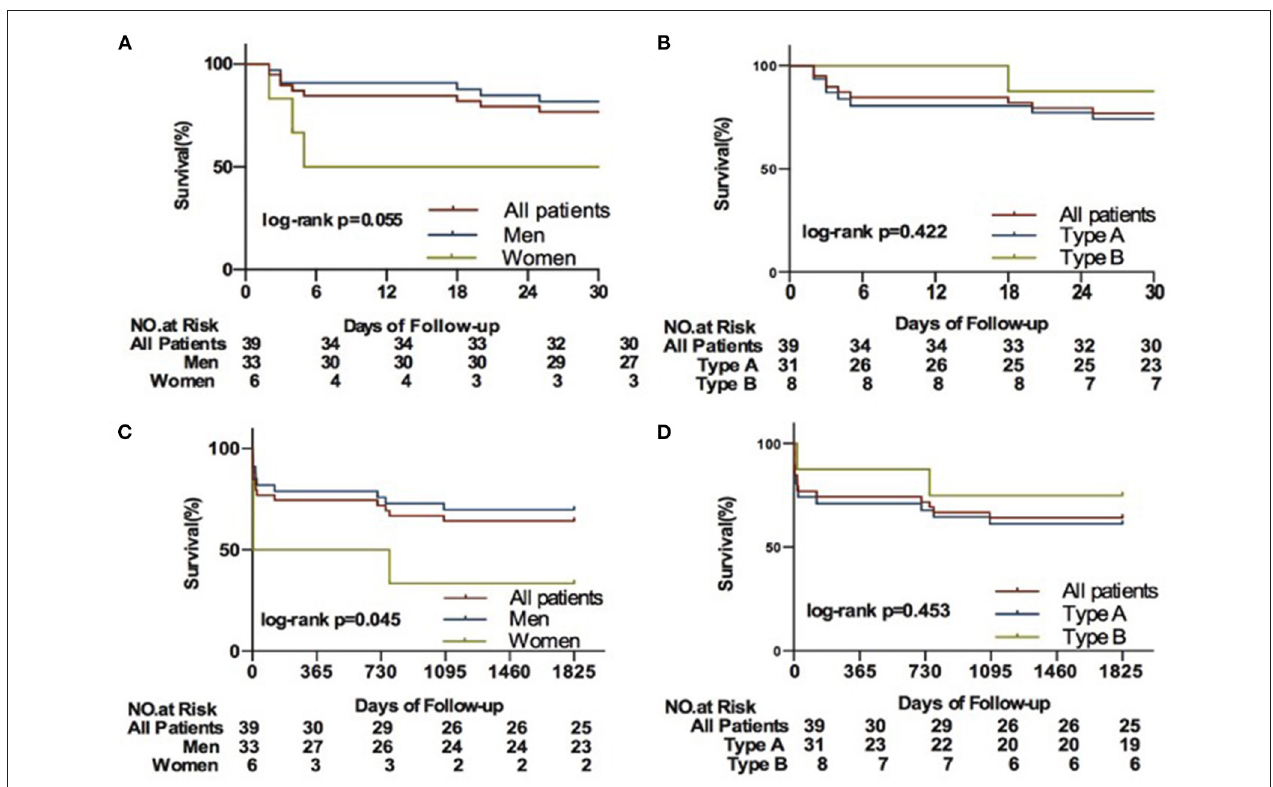
FIGURE 3 | Kaplan-Meier curves for clinical outcomes in the 39 patients with AD with AMI. (A) , Kaplan-Meier curves for 30 days between men and women; (B) , Kaplan-Meier curves for 30 days between Type A and Type B; (C) , Kaplan-Meier curves for 5 years between men and women; (D) , Kaplan-Meier curves for 5 years between Type A and Type B; AD indicates aortic dissection; AMI, acute myocardial infarction.